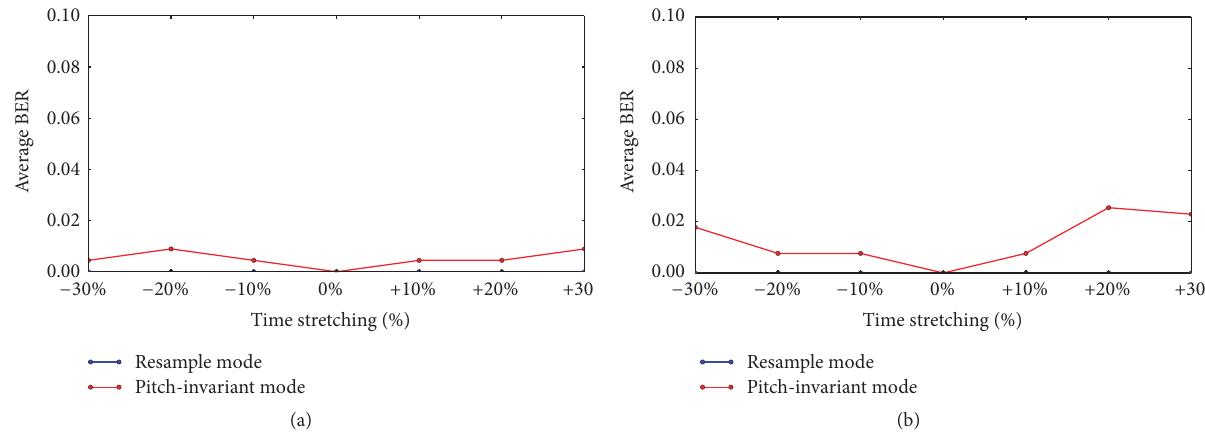
Figure 5: Robustness against TSM attacks with 𝐿 𝐵 = 128 and sync = 𝑊 . (a) 32 bit watermark; (b) 56 bit